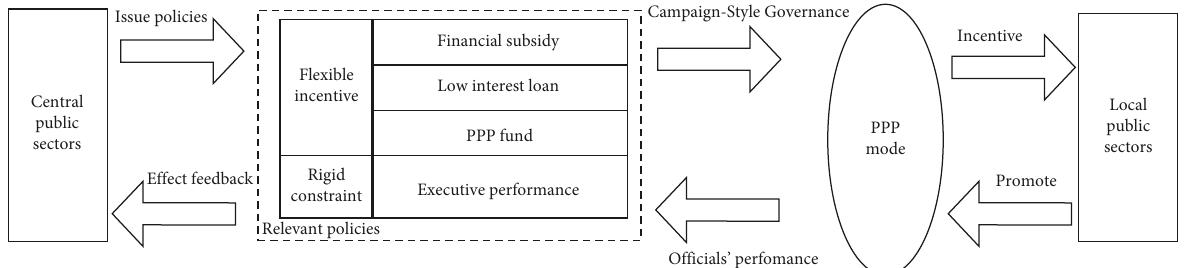
Figure 1: Campaign-Style Governance of the PPP movement.